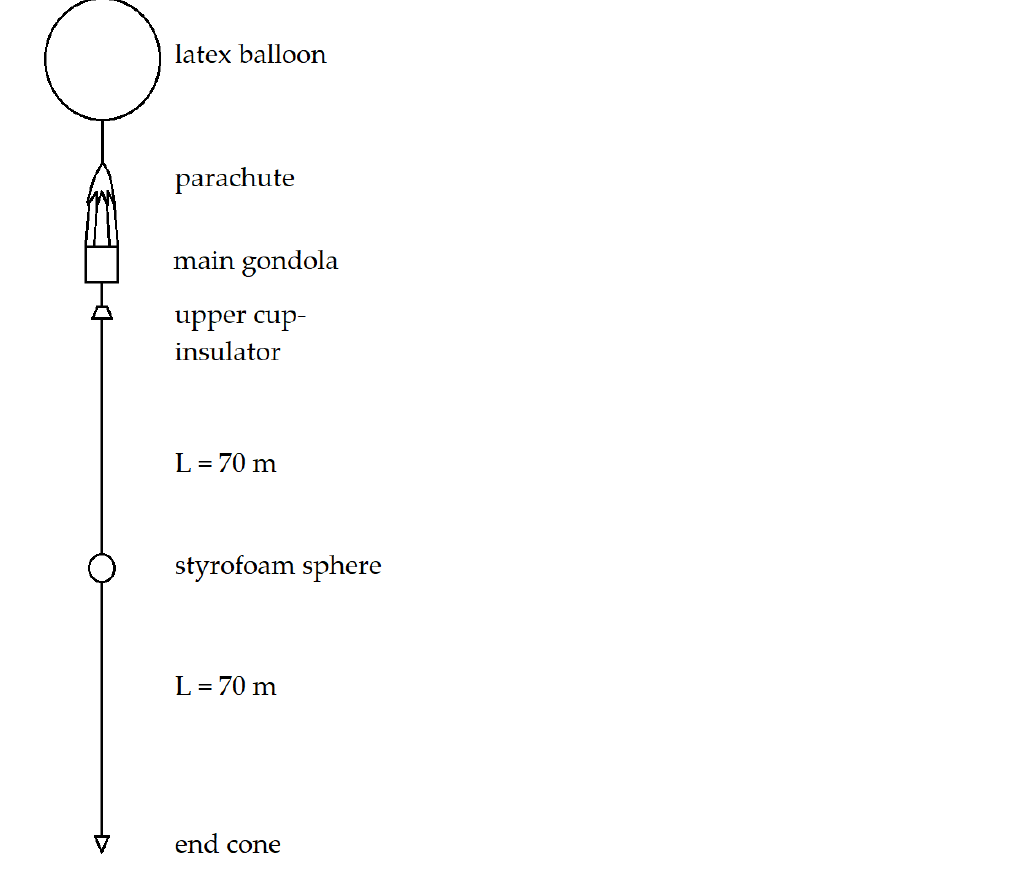
Figure 4. The general schematic of the balloon mission used in the analysis. The antenna wire lengths are not to scale. The schematic does not include small red flags made of non-conductive fabric, placed evenly on the antenna to provide enhanced visibility.